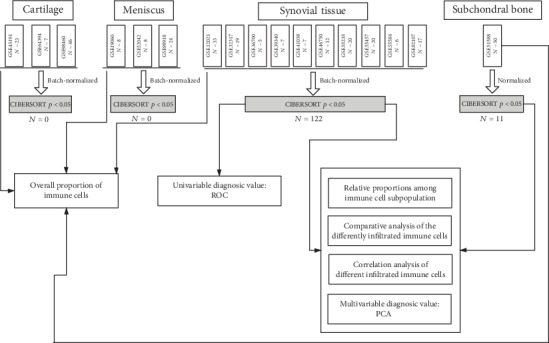
Flowchart detailing the study design. GEO: Gene Expression Omnibus; CIBERSORT: Cell-type Identification By Estimating Relative Subsets Of known RNA Transcripts; PCA: Principle component analyses; ROC: receiver operating characteristic.